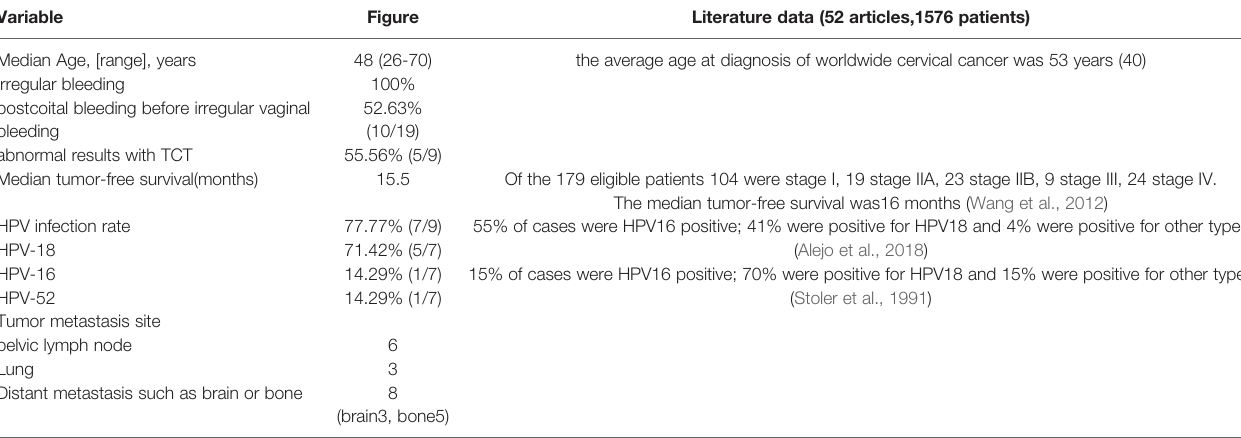
TABLE 1 | Ordinary statistics of patients. Variable Figure Literature data (52 articles,1576